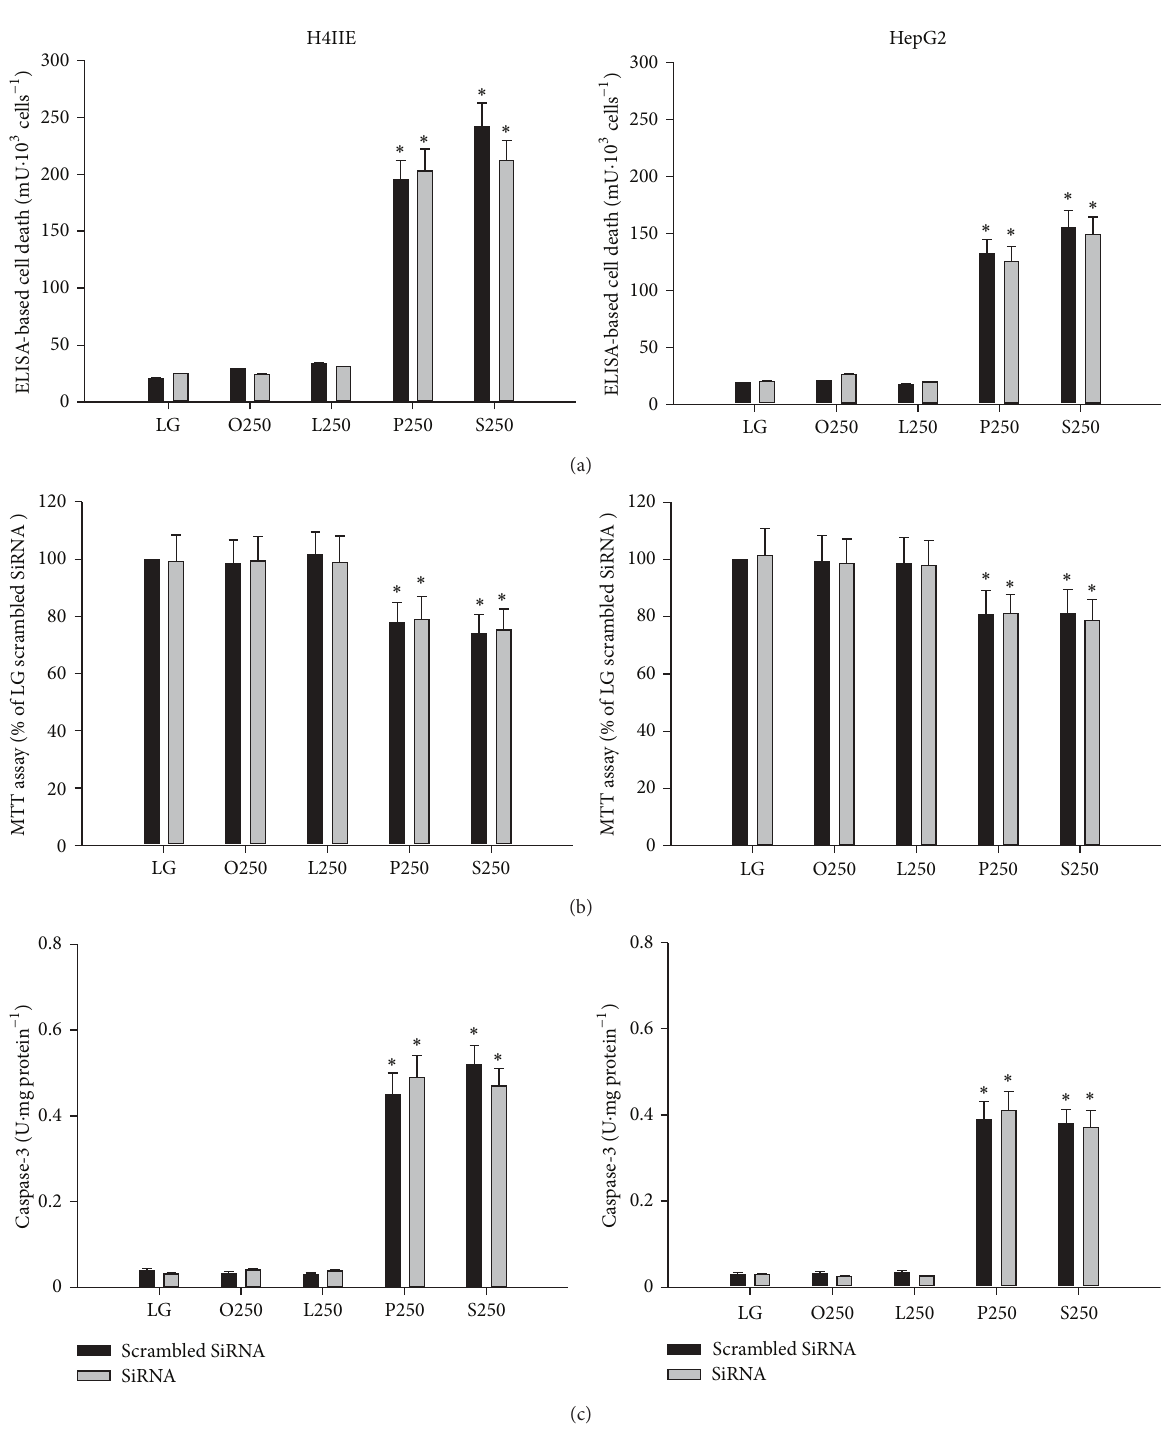
Figure 3: Cell viability in H4IIE and HepG2 liver cells. ELISA-based cell death (a), MTT assay (b), and caspase-3 activity (c) in H4IIE (left column) and HepG2 (right column) liver cells following 16h of incubations with control media (LG) or fatty acids (oleate (O), linoleate (L), palmitate (P), or stearate (S)) at 250 𝜇 M in the absence (Control) or presence of PTEN knockdown (SiRNA) ( 𝑛 = 6 ). ∗ : significantly ( 𝑃 < 0.05 ) different from LG, O250, and